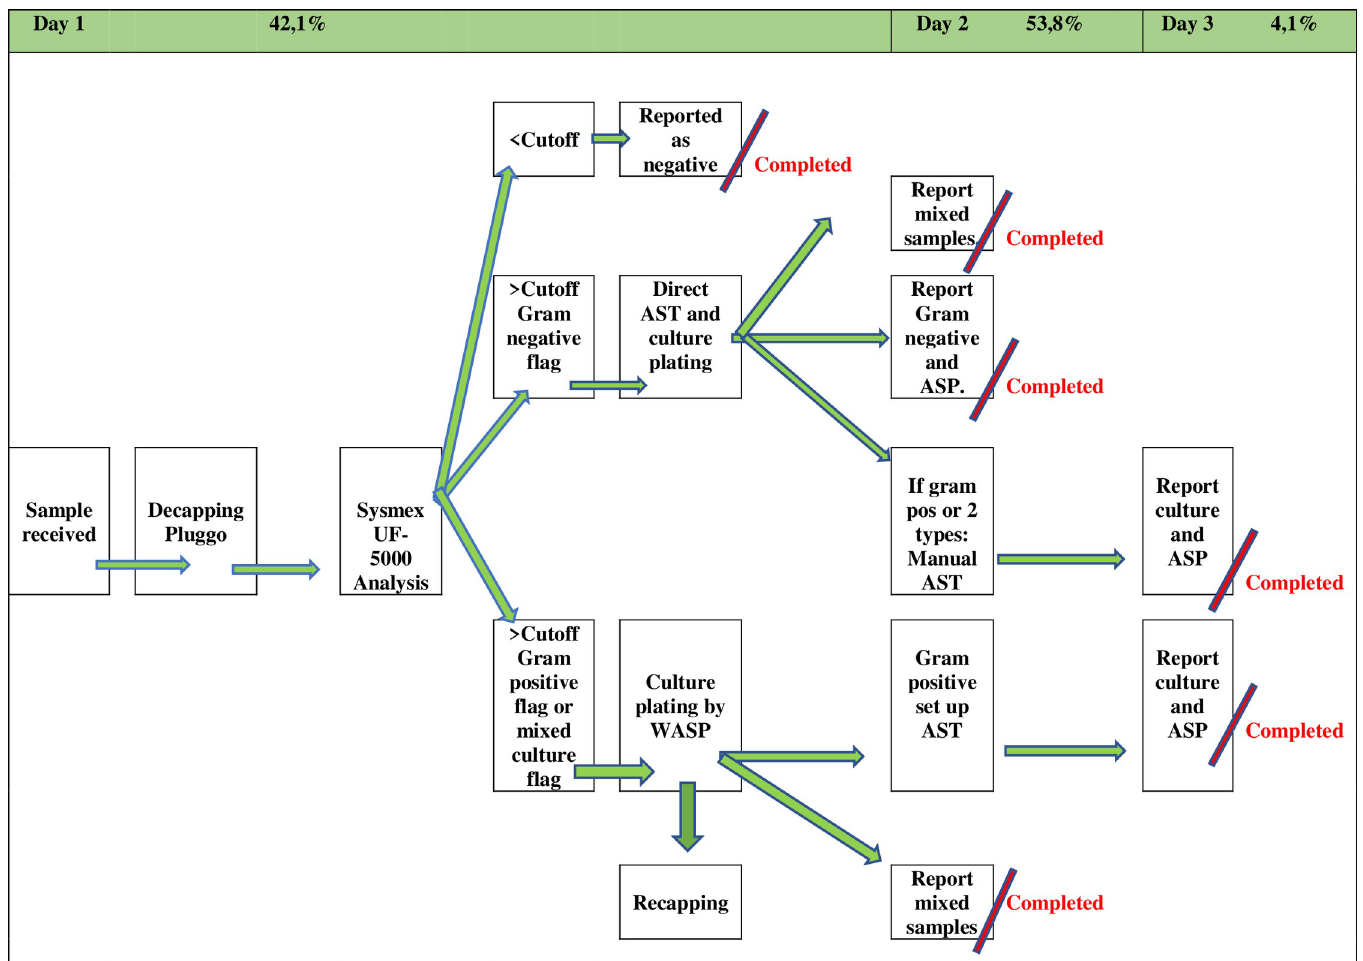
Fig 4. Algorithm of UTI diagnosis using flowcytometry with reported samples on different days.